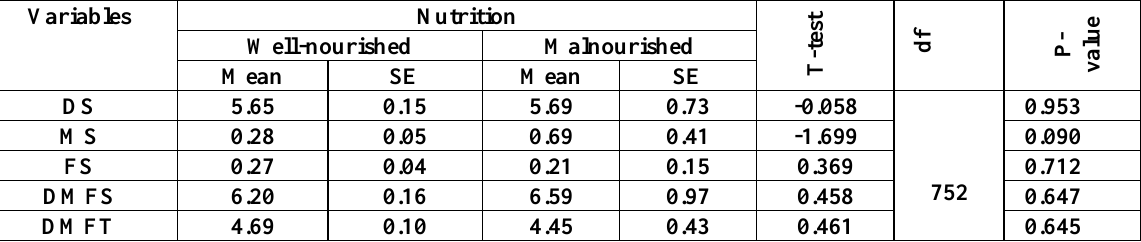
Table 8: Caries experience of the permanent teeth (mean and standard error) among students by nutritional